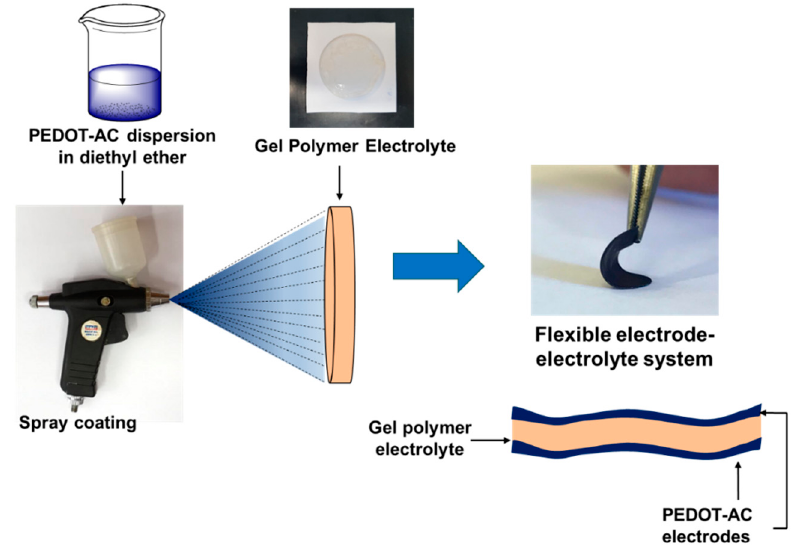
Table 1. Characteristics of PEDOT-AC composite materials